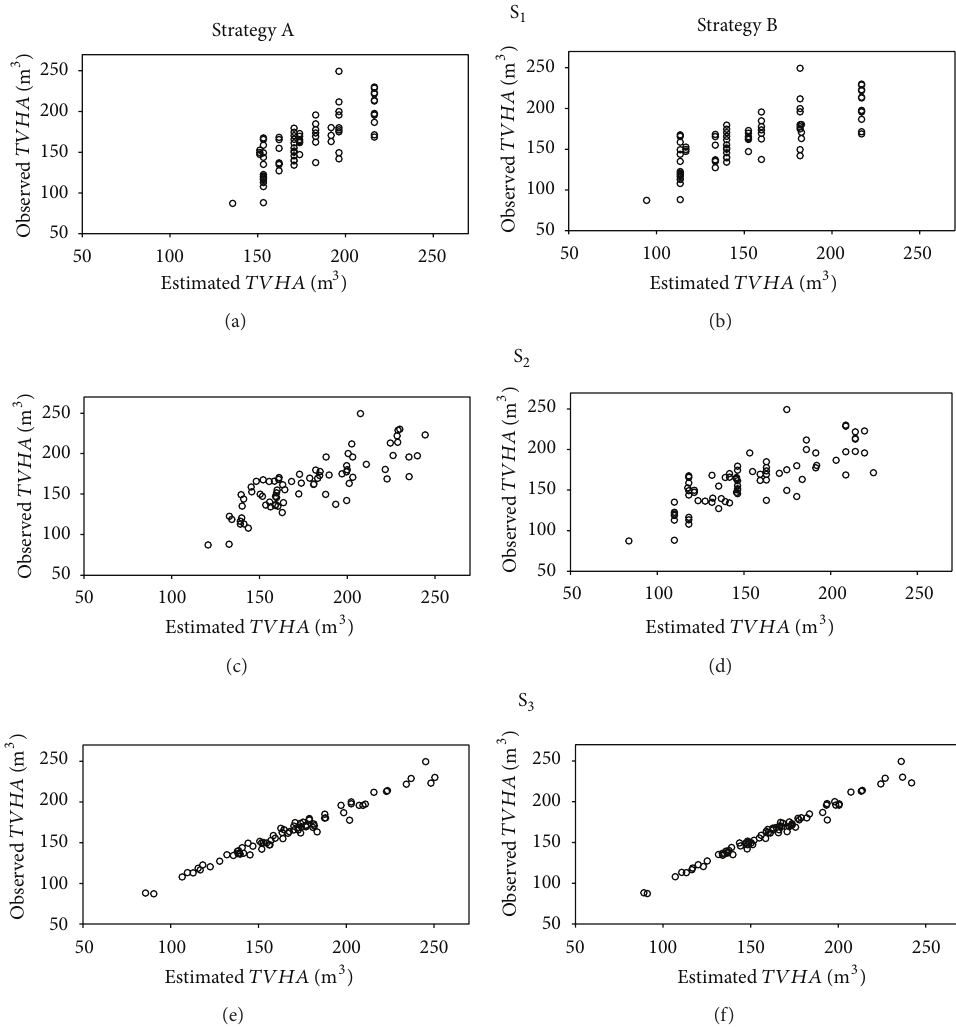
Figure 3: Scenarios for the estimates of the total volume at five years of age by Strategies A and